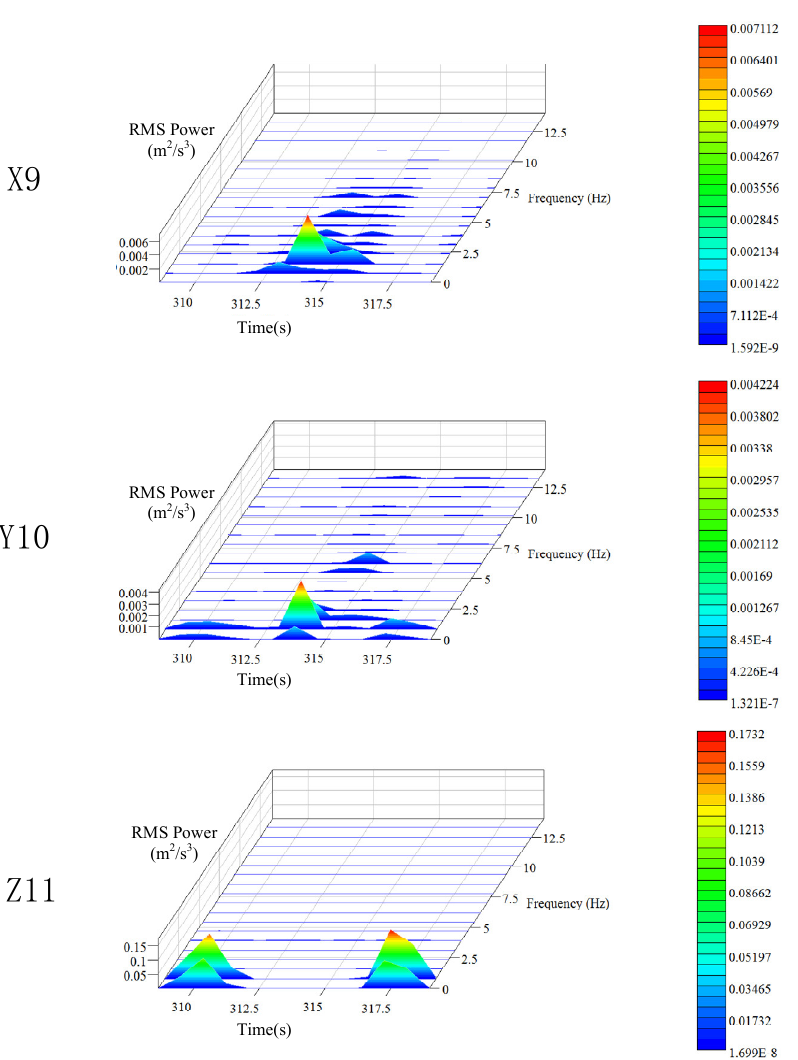
Figure 6. Time-frequency characteristics of the platform frame.